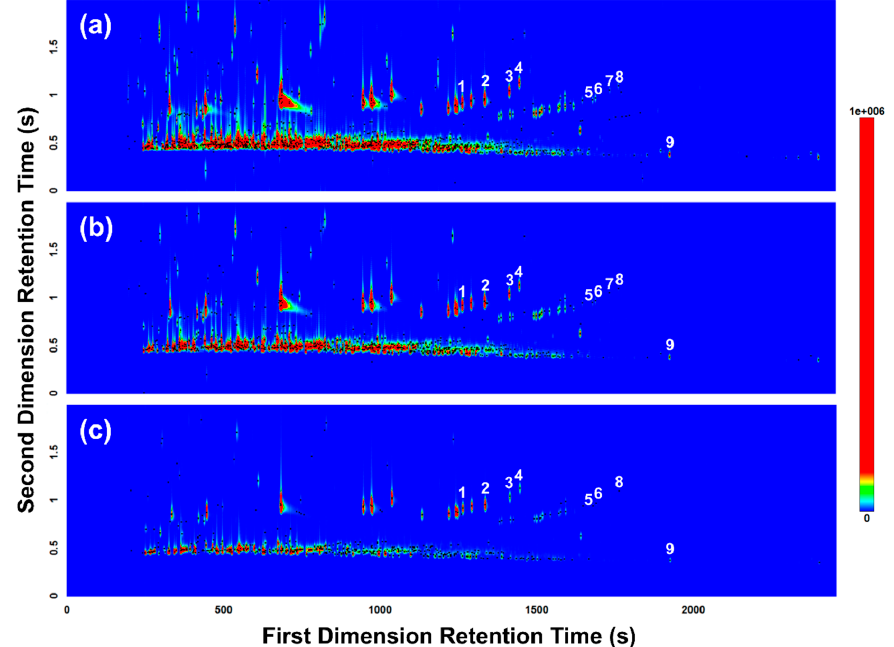
Figure 3. GC × GC-TOFMS total ion current (TIC) contour plots of headspace samples collected from the pig carcass burnt with gasoline and analyzed with three different tube desorption/trap desorption split flow conditions: ( a ) 20 mL/min/20 mL/min (split ratio = 15.4:1); ( b ) 20 mL/min/50 mL/min